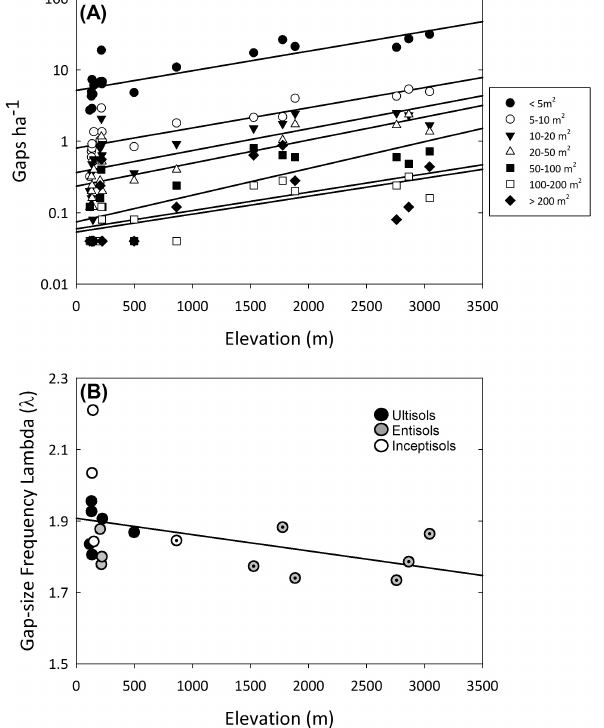
Fig. 3. (a) Changes in mean canopy gap density with increasing elevation for each 25ha forest landscape. Gaps are computed to 2m above ground level (Brokaw, 1985a) in seven gap-size classes from <5m 2 to >200m 2 per gap. (b) Changes in the gap-size frequency scaling coefficient λ for each landscape along the elevation gradient. Symbols are colored by USDA soil order; and dots within circles indicate sites included in elevation-based regression of main text.